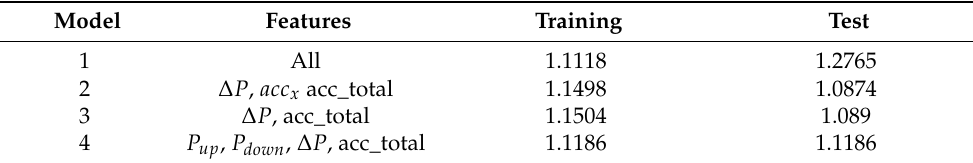
Figure 46. Linear regression predictions on the test sets. The orange dashed line is the velocity predicted by the model, the blue solid line is the target velocity, and the gray line is the absolute error, defined as the target velocity minus the predicted v. Table 5. Performance of the linear regression models. Each model used a different combination of features. All means that the model used all the features from the data